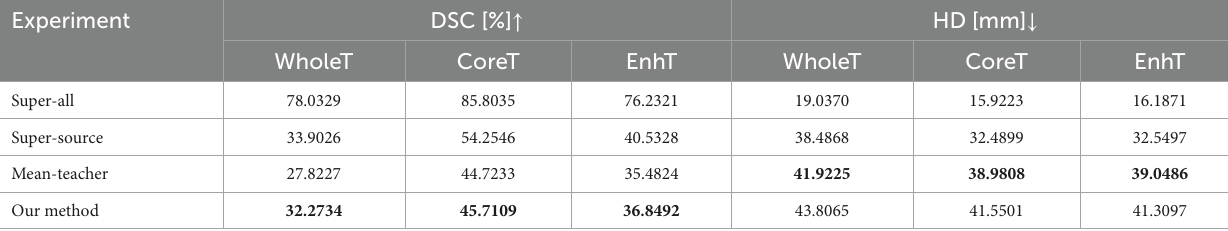
TABLE 2 Quantitative comparisons of DSC and HD in the T2 + FLAIR to T1 + T1ce UDA task. Experiment